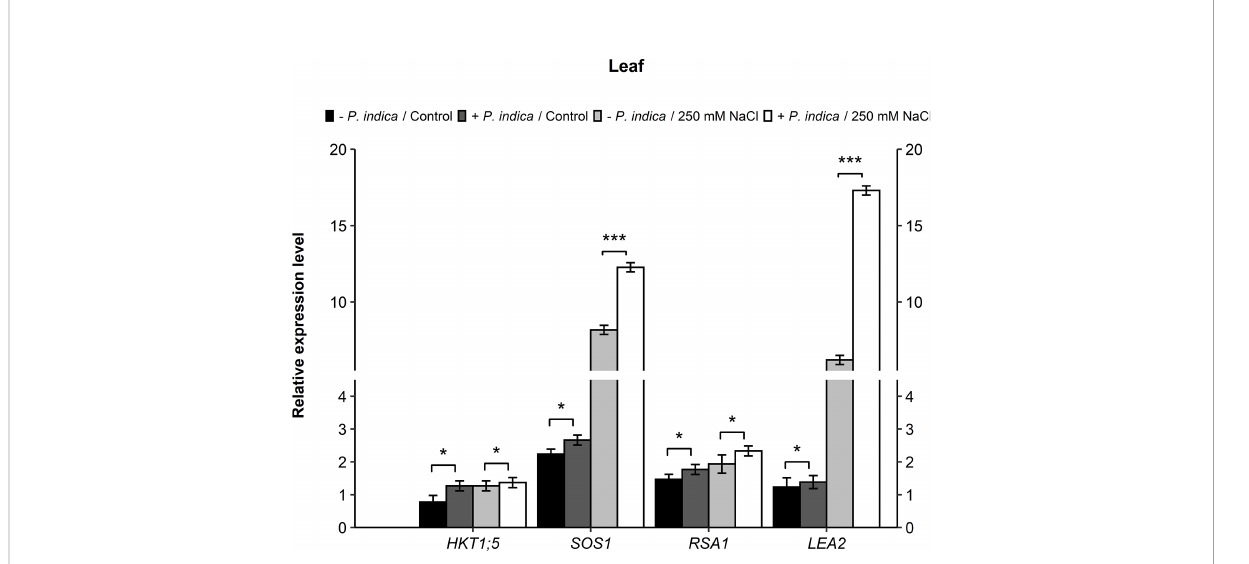
FIGURE 6 Relative expression of candidate genes ( HKT1;5, SOS1, RSA1, and LEA2 ) in leaves of P. indica inoculated date palm seedlings grown under control and salt stress conditions. The values are the means ± SD (n = 3), analyzed by Student ’ s t- test, *p < 0.05 and ***p < 0.001.